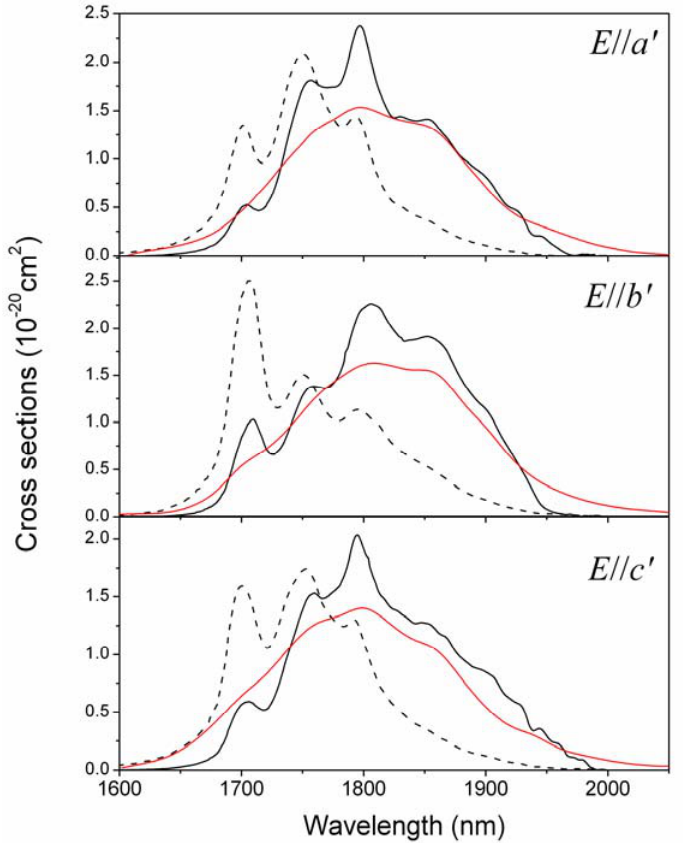
Ba Gd (MoO ) crystal for the 3 F 3 2 3 4 8